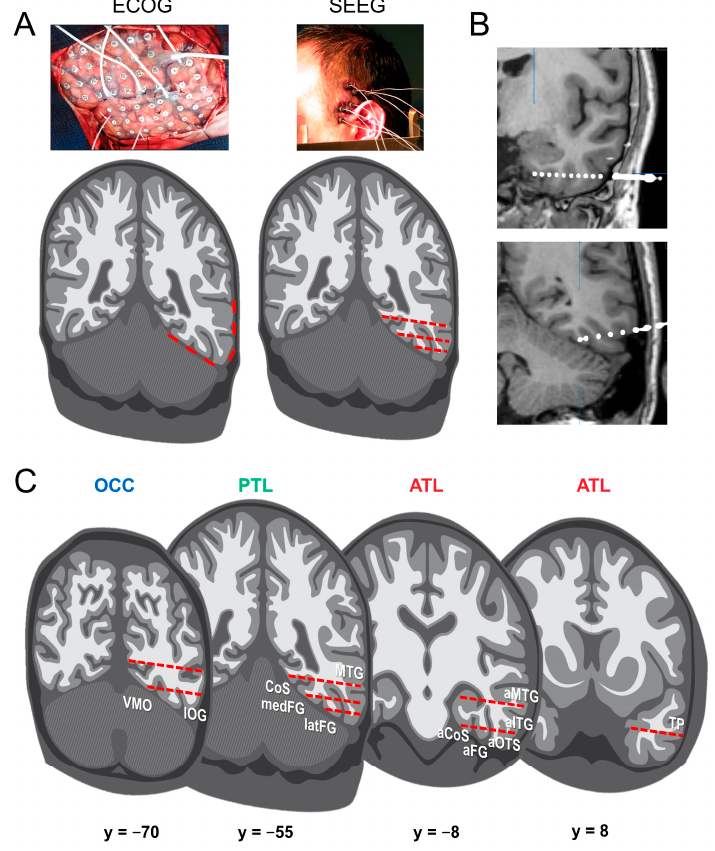
Figure 1. ( A ) Intracranial recordings in human epileptic patients are performed either with subdural grids of electrodes (Electro-CorticoGraphy, ECoG, on the left) or electrodes inserted inside the cortex and subcortical structures (Stereo-ElectroEncephaloGraphy, SEEG, on the right). In ECoG, part of the skull is removed to apply electrodes onto the cortical surface (here, grids of electrodes; see lower row for example electrode locations, in red, on a schematic coronal slice). In SEEG, small holes are drilled in the skull to implant thin depth electrodes. Lower row: Recording contacts from typical electrode trajectories are represented in red. The two techniques differ in terms of their advantages, both in terms of clinical investigations and associated research purposes. The present review focuses on SEEG, which is growing in usage across the world for clinical reasons (less invasive since there is no craniotomy, reduced incidence of infections, and hemorrhages; [31,34,35]. ( B ) Examples of SEEG electrodes in two patients as they appear when co-registering the pre-operative MRI with the post-operative CT-scan (white ‘dots’ on the coronal slices; top: electrode in the ATL, bottom: electrode in PTL targeting the latFG). Each electrode typically contains 8–15 contiguous individual recordings sites (or contacts). ( C ) Typical locations of electrodes implanted (across patients) in the ventral occipito-temporal cortex, as reviewed here (OCC: occipital; PTL: posterior temporal lobe; ATL: anterior temporal lobe. See below for abbreviations of specific cortical structures).